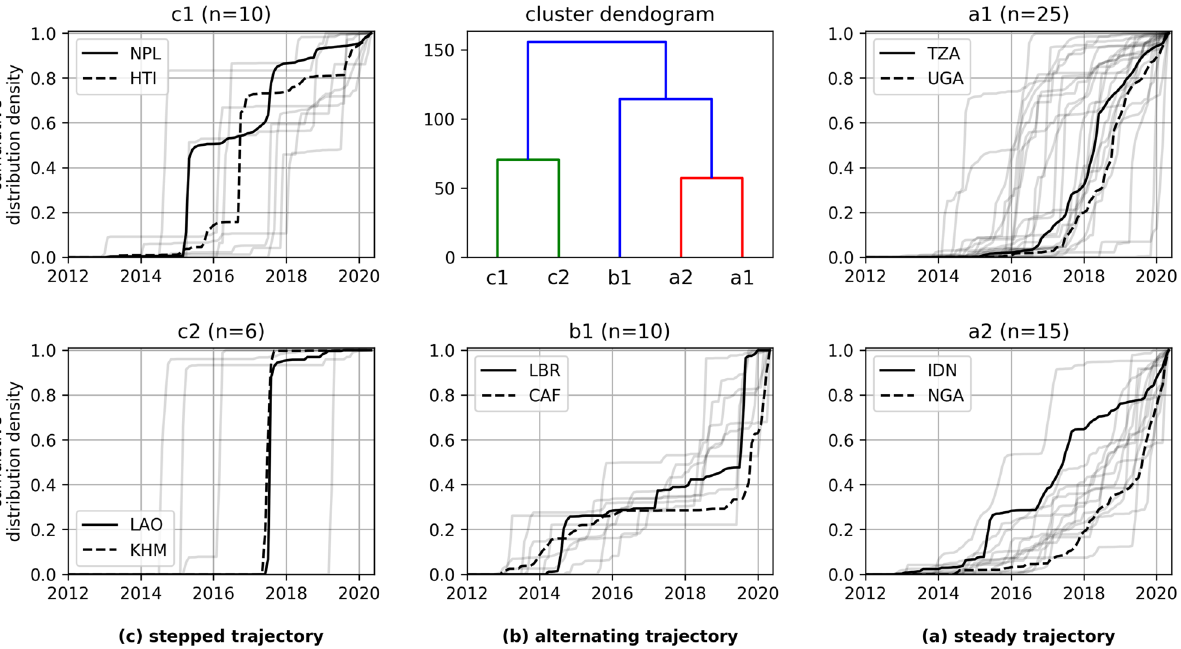
Figure 6. Cluster dendogram and cumulative distribution density plots for monthly humanitarian OSM building mapping between 2012/01/01 and 2020/05/20. This plot depicts the values for all countries with medium and low human development index (SHDI<0.7). The groups are defined by a hierarchical clustering approach based on a distance matrix derived from dynamic time warping time series similarity analysis. For each group the trajectory for the two countries with highest overall mapping activity are highlighted. We used alpha-3 ISO 3166 codes to refer to the countries: TZA - Tanzania, UGA - Uganda, NPL - Nepal, HTI - Haiti,